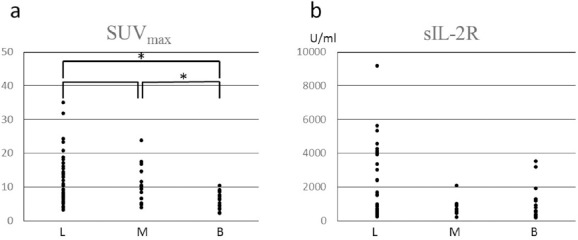
SUVmax and sIL-2R in three groups;a: There was a significant difference in SUVmax between the three groups (P=0.002; Kruskal-Wallis test). Mann-Whitney test revealed that the groups L and M showed significantly higher SUVmax than that of group B (P<0.05*).b: There was no significant difference in sIL-2R between the three groups (P=0.068; Kruskal-Wallis test).Note: Group B, group of benign diseases; Group L, group of lymphoma; Group M, group of other malignancies; sIL-2R, soluble interleukin-2 receptor; SUVmax, maximum standardized uptake value